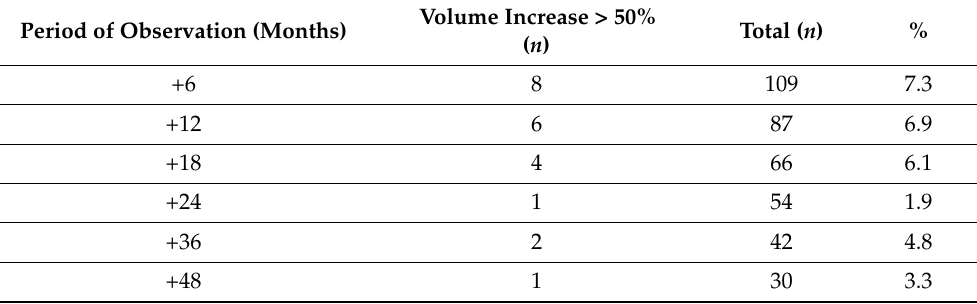
Table 2. Volume increase ≥ 50% at different time evaluations.